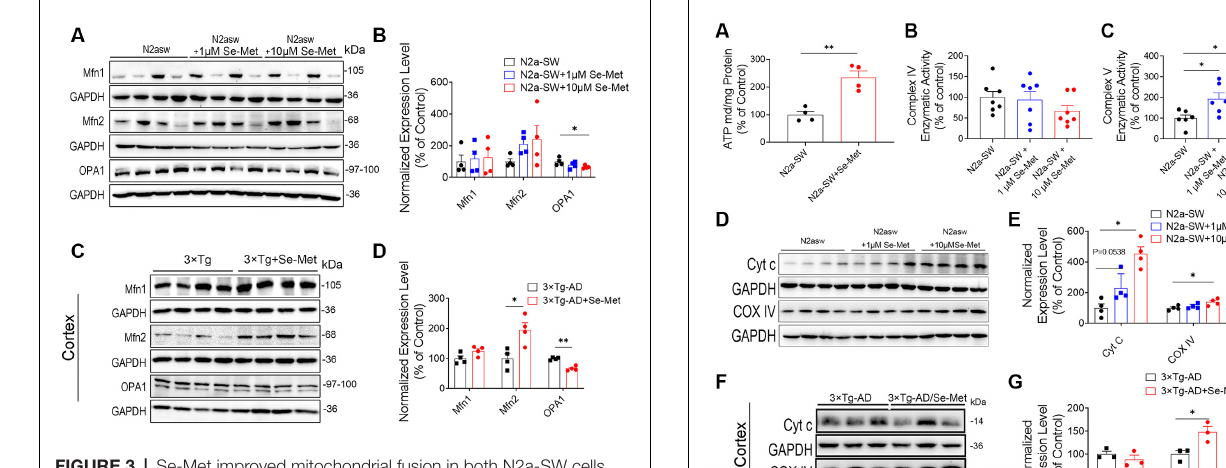
FIGURE 3 | Se-Met improved mitochondrial fusion in both N2a-SW cells and AD mice. (A) The levels of Mfn1, Mfn2, and OPA1 in N2a-SW cells were detected by western blot analysis. (B) Quantitative analysis of these proteins ( ∗ p < 0.05 vs. the control group. n = 4). (C) The levels of Mfn1, Mfn2, and OPA1 in the cortices of AD mice were detected by western blot analyses. (D) Quantitative analysis of these proteins ( ∗ p < 0.05, ∗∗ p < 0.01 vs. AD mice. n = 4 mice).